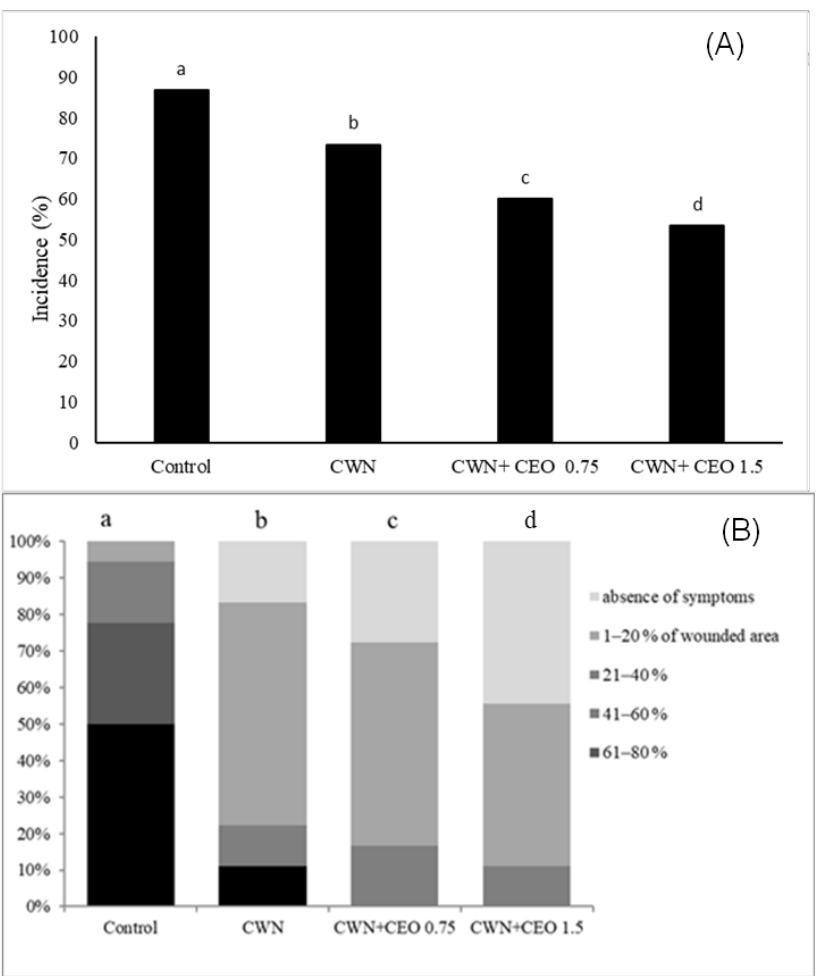
Figure 2. Fruit incidence ( A ) and severity ( B ) evaluation at the end of the storage period of 12 days at 16 ◦ C for (a) uncoated, (b) CWN, (c) CWN + CEO 0.75%, and (d) CWN + CEO 1.50%. Control: un- coated fruit; CWN: carnauba wax nanoemulsion at 9% of solid phase in suspension; CEO: C. martinii essential oil at 0.75% or 1.50%. Distinct letters represent a significant difference between treatments by the Kruskal–Wallis test ( p < 0.05).